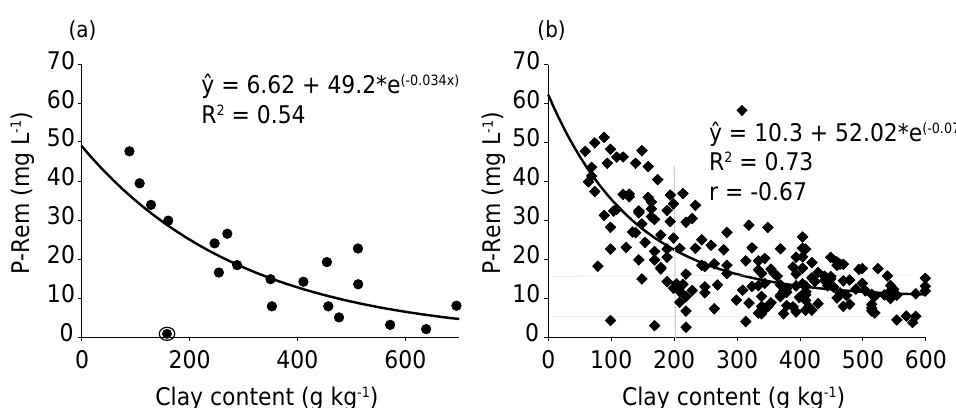
Figure 1. P-remaining (P-Rem) as a function of the clay content in different soil samples. (a) Soils used in the studies with plants; (b) Soils from different regions of the state of RS (200 samples).